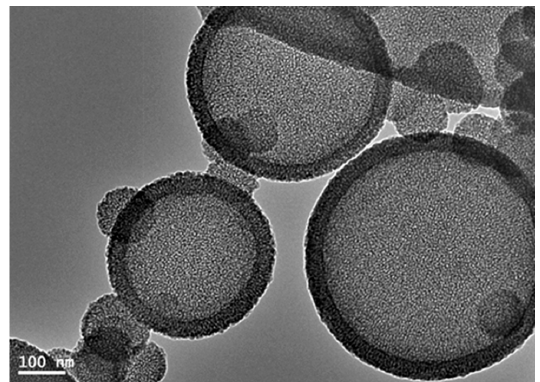
Figure 1. TEM images of amino-functionalized hollow core-mesoporous silica (HCMSS–NH 2 ) nanospheres prepared by anionic surfactant.